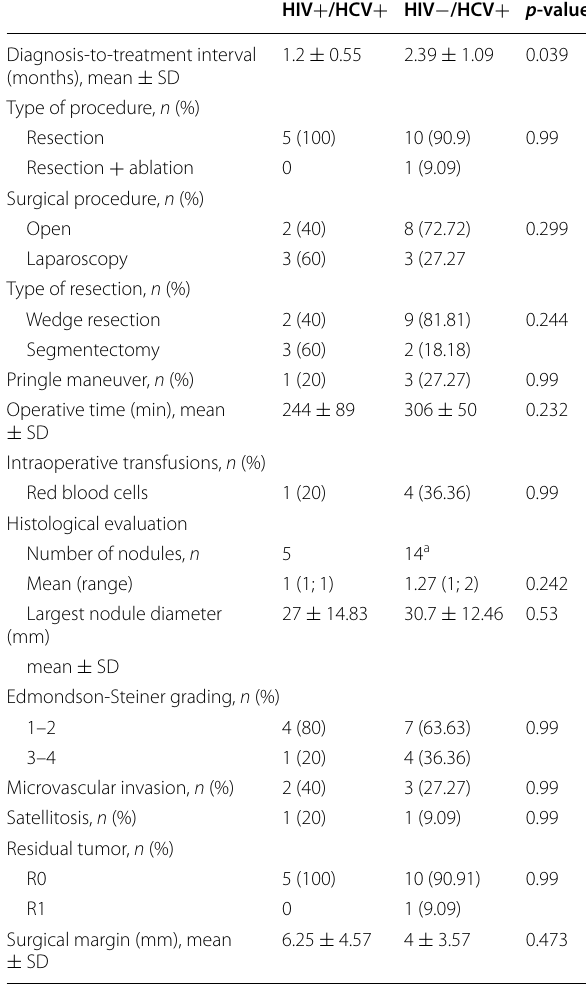
a SD standard deviation, one nodule identified at imaging was treated with